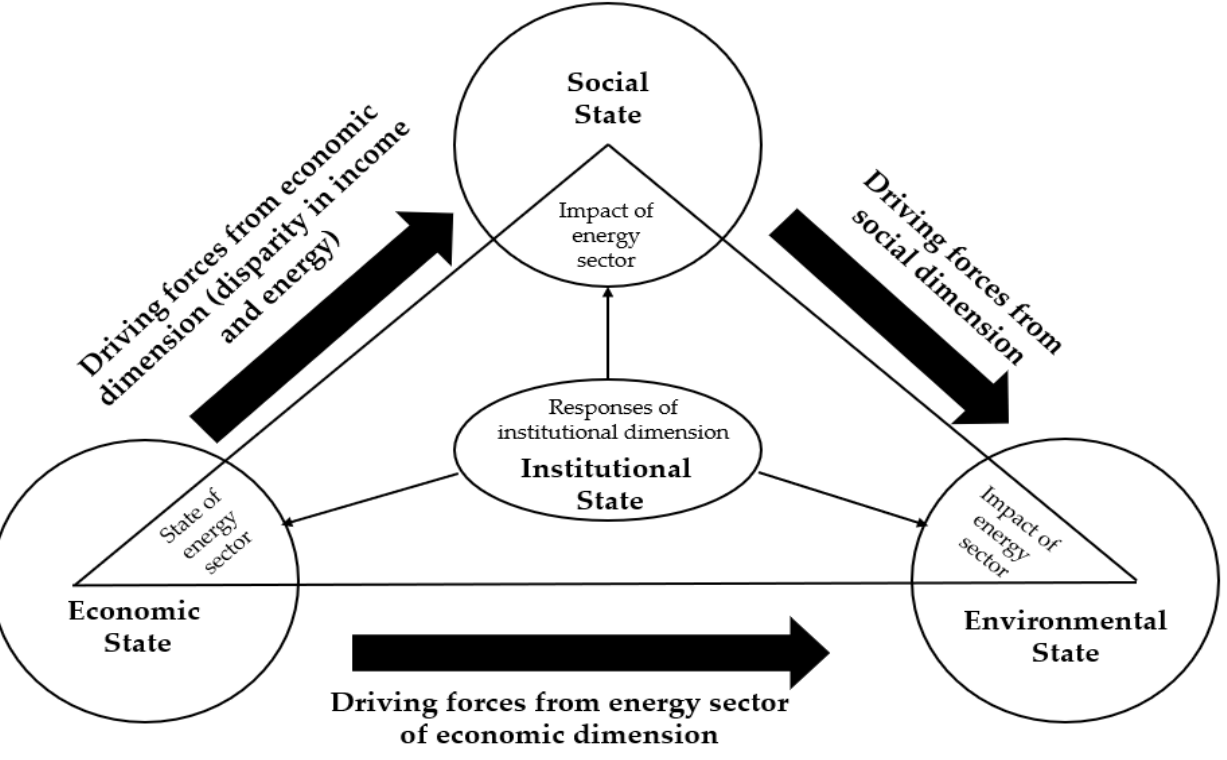
Figure 1. Interrelationship among sustainability dimensions of the energy sector.